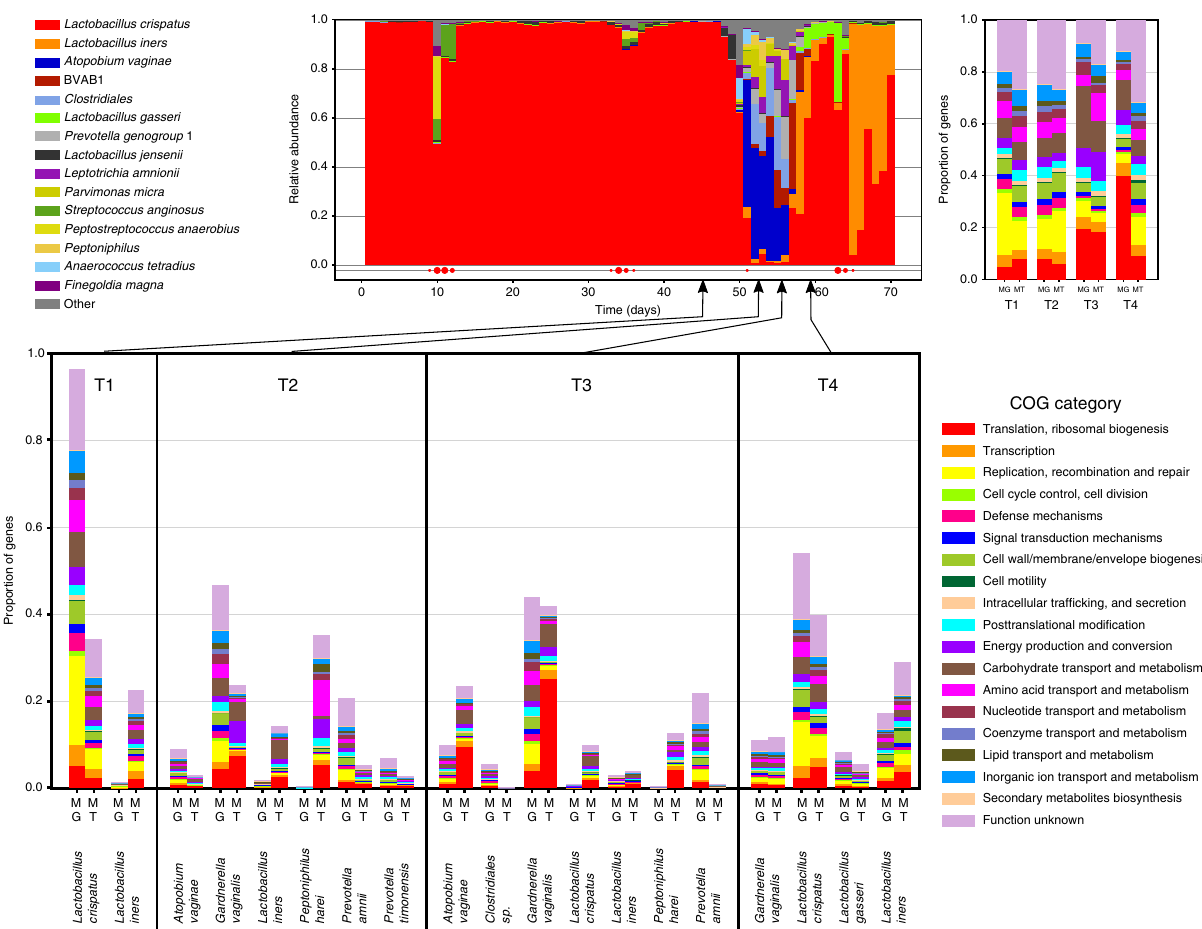
Fig. 5 Demonstration using VIRGO and VOG to study vaginal microbiome. a 4 sampling points were selected based on a longitudinally pro fi led subject prior to (T1), during (T2 and T3), and after (T4) an episode of bacterial vaginosis using 16S rRNA pro fi ling. b Functional pro fi ling of the metagenome (MG) and metatranscriptome (MT) of each of the four sampling points. Functional categories were annotated using EggNOG (v4.5) 59 . c Functional pro fi les strati fi ed by species using the taxonomic pro fi ling provided by VIRGO. d Demonstrative use of VOG to characterize the G. vaginalis cholesterol-dependent cytolysin (CDC) protein family. It shows the phylogeny of CDC-containing protein and alignment of domain 4 of the CDCs that is generally well conserved but contains a single divergent site, highlighted in